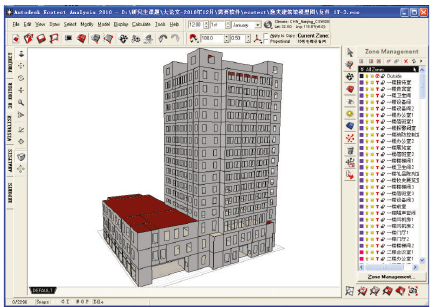
Figure 4: The RRSAB model built in Ecotect.